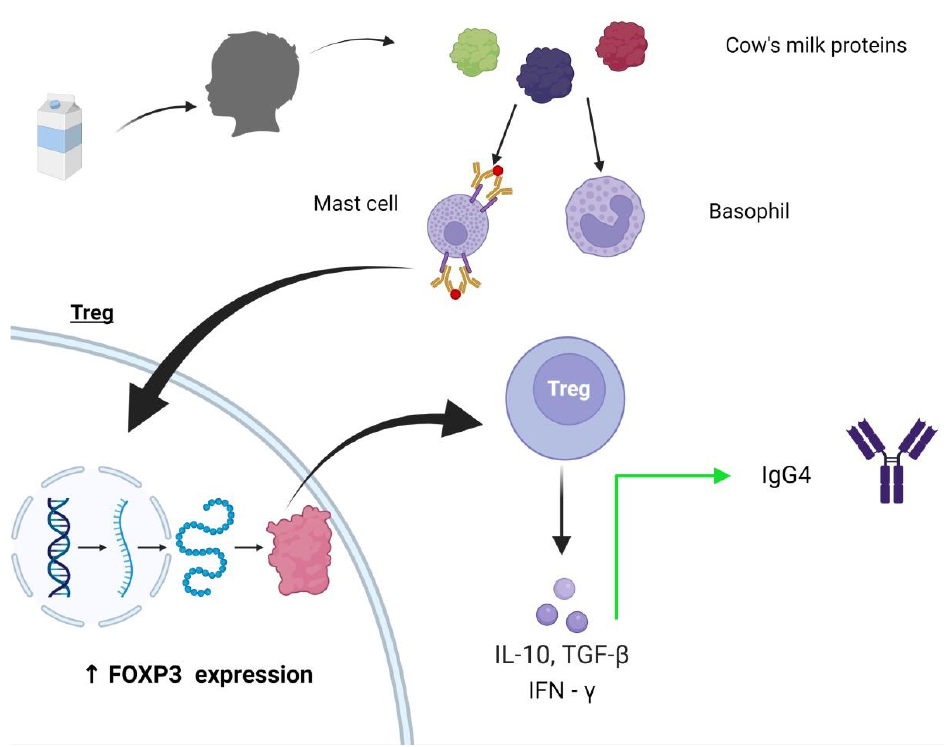
Figure 4. Describing mechanism of oral immunotherapy.